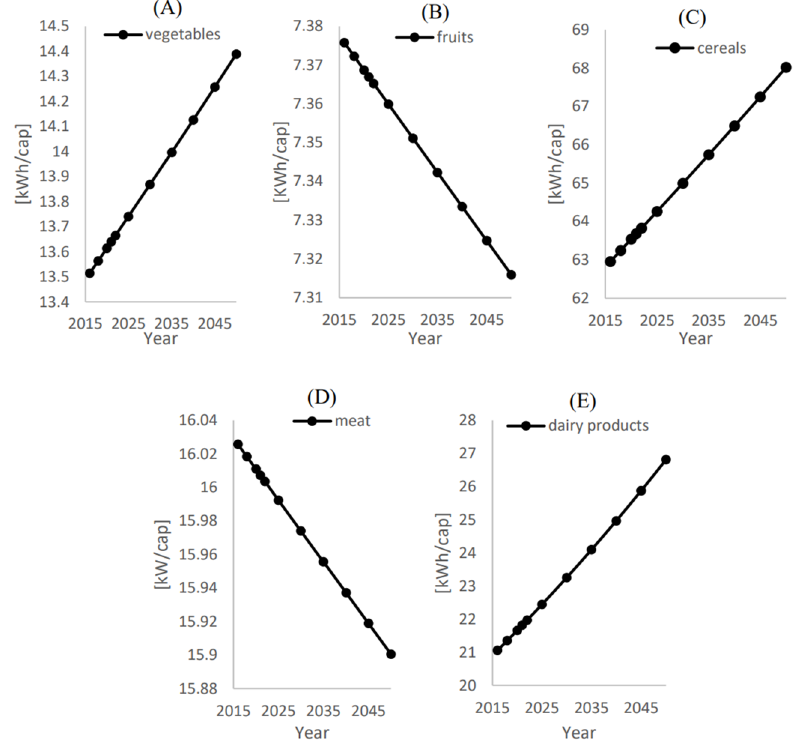
Figure 11. Energy consumption ( E i ) per capita [kWh/cap] for local food supply ( x i ) for ( A ) Vegeta- bles, ( B ) Fruits, ( C ) Cereals, ( D ) Meat, and ( E ) Dairy products.